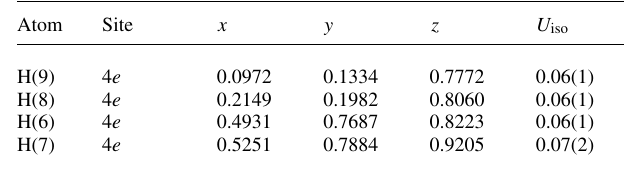
Table 2. Atomic coordinates and displacement parameters (in Å 2 )